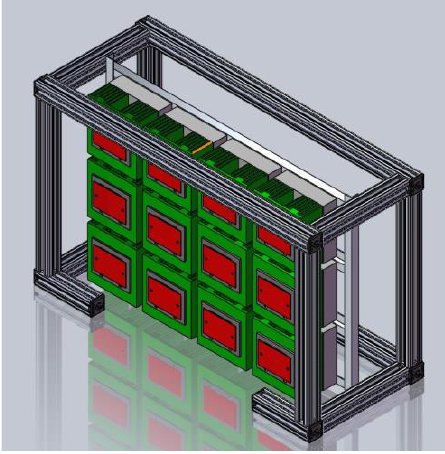
Figure 4: Original 4 TEC Platform